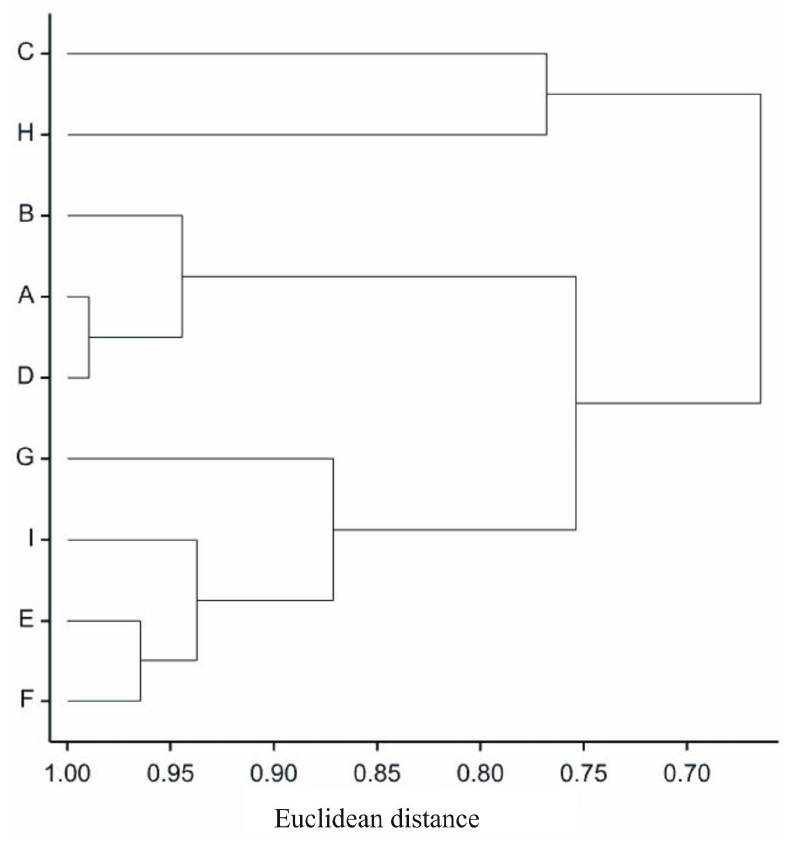
Figure 6. Clustering (an average is taken over all the units in the two merged clusters) of habitats based on five morphological traits. The length of the lines indicates the similarity/distance between two habitats or among two groups of habitats and stated hierarchical clusters, A–I abbreviated habitat names (see: Table 1). 3.3. Intraspeci fi c Variability of Pollen Grains Depending on the Analyzed Habitats In six habitats (A, B, D, E, G and H), signi fi cant variation was observed between sam- ples for all the observed traits (Table 7). In habitat C, no signi fi cant variation was found between samples for LA/SA only, while in habitat F it was observed for Ex/LA. In habitat I, signi fi cant variation between samples was observed for two traits: LA/SA and Ex/LA (Table 7). The habitats with a larger number of samples tend to have greater variability than the habitats with a smaller number of samples.